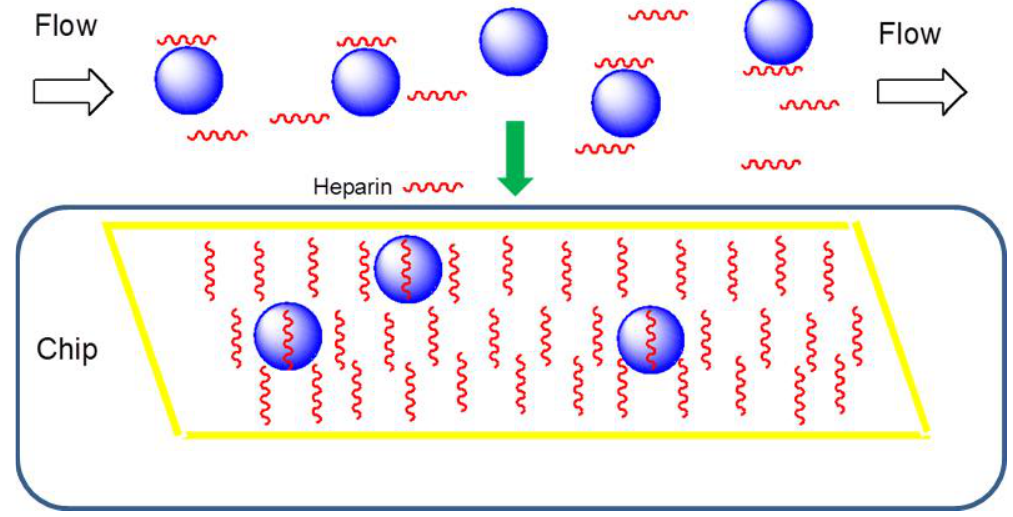
Figure 2. Diagram of SPR solution competition study. The blue spheres represent TIMP-3 protein, the short red helices represent heparin or other GAGs. TIMP-3 protein (pre-mixed with 1000 nM heparin oligosaccharides or GAG) was injected over a chip containing immobilized heparin; only free protein can bind to the heparin on the